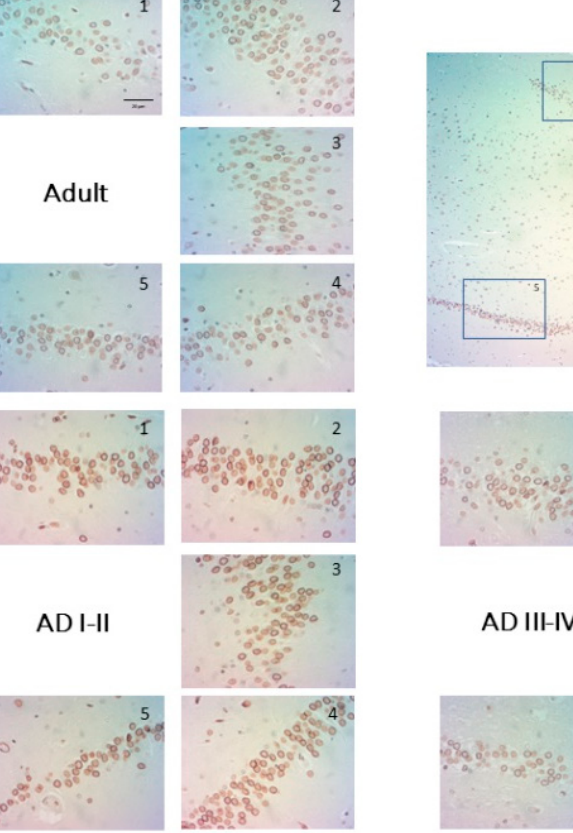
Figure 2. Lamin B2 distribution in the nuclei of DG neurons. Center: Panoramic view of human DG indicating fields ( 1 – 5 ) of microphotographs and digital quantification of immunopositivity. Scale bar: 100 µm. Five representative microphotographs of adult, senile, and AD stages I–VI. Scale bar: 20 µm. Intermediate and late AD stages (III–VI) show the highest amount of Lamin B2 positivity limited to perinuclear borders.